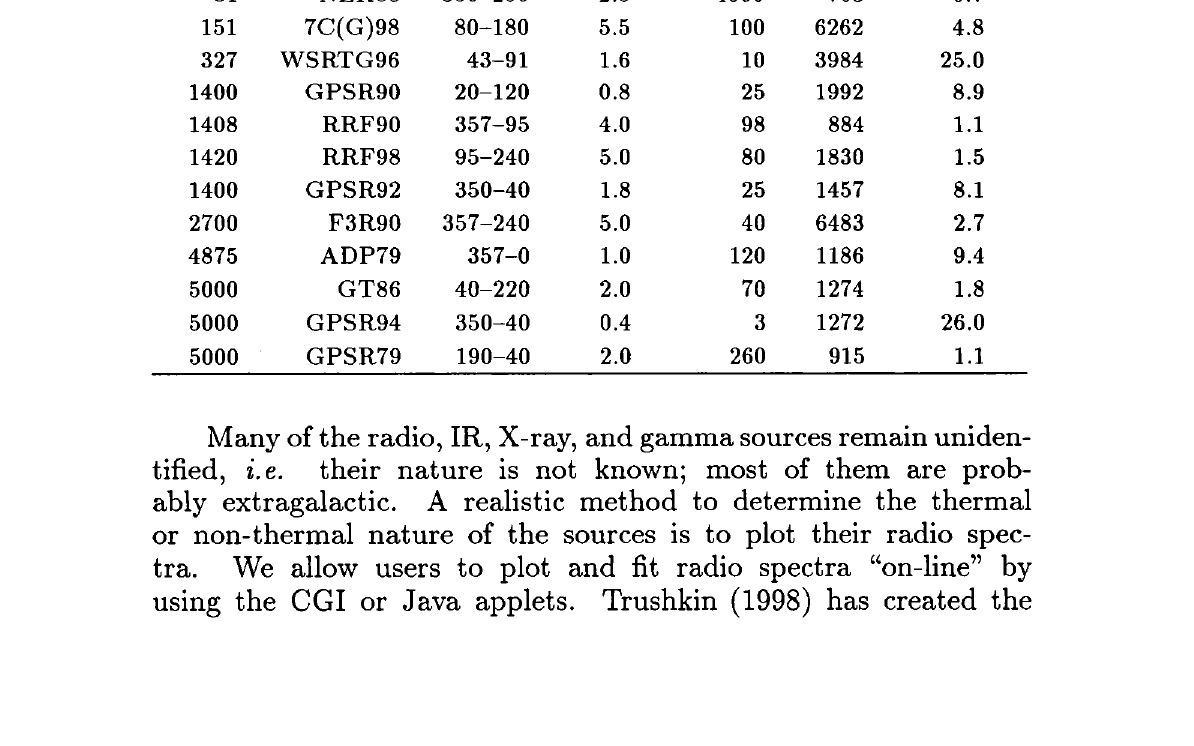
Table 1. The major Galactic plane surveys in CATS. Freq Name Gal. Gal.lat. ^min Num. Ν per